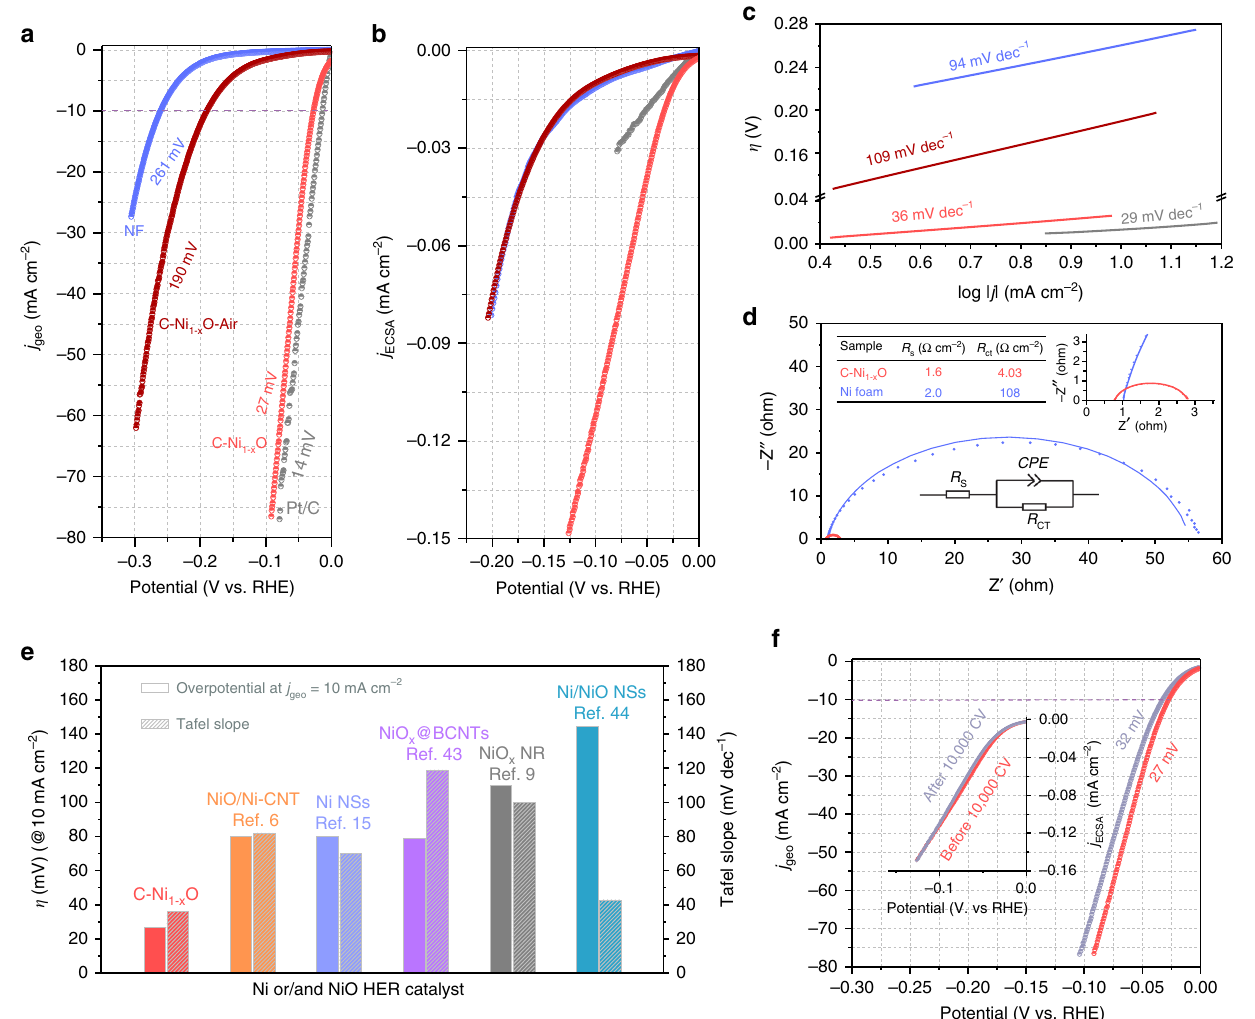
Fig. 6 HER performances of C – Ni 1 − x O. a HER polarization curves obtained from NF, C – Ni 1 − x O – Air, C – Ni 1 − x O, and Pt/C in 1.0 M KOH saturated with nitrogen at a scan rate of 1 mV s − 1 . b Polarization curves of Pt/C, NF, C – Ni 1 − x O – Air, and C – Ni 1 − x O with current normalized to ECSA. c Tafel plots of the NF, C – Ni 1 − x O – Air, C – Ni 1 − x O, and Pt/C. d Electrochemical impedance spectra of the NF and C – Ni 1 − x O measured at the potential of − 0.15 V vs RHE, with frequency ranging from 100 kHz to 1 Hz and an amplitude of 5 mV. Dots and solid lines are the experimental data and simulated results based on the equivalent circuit illustrated in the inset, respectively. e The comparison of the overpotential at 10 mA cm − 2 and Tafel slopes of C – Ni 1 − x O with the reported state-of-the-art Ni- and NiO-based HER catalysts, including NiO/Ni-CNT 6 , Ni nanosheets (NSs) 15 , NiO x @Bamboo-like CNTs (BCNTs) 43 , NiO x nanorods (NRs) 9 , and Ni/NiO NSs 44 . f Polarization curves of the C – Ni 1 − x O collected before and after 10,000 cycles. Inset fi gure shows the polarization curves with current normalized to ECSA. All of the data here are iR